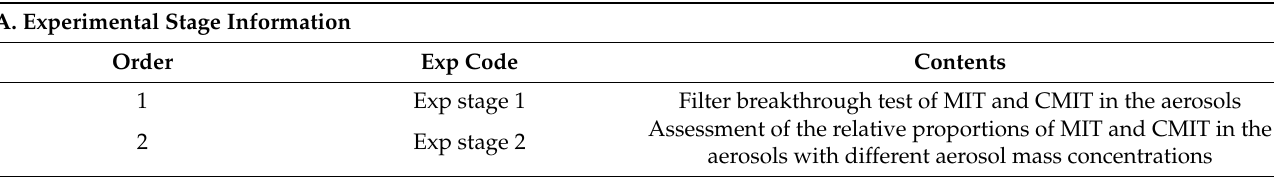
Table 2. Experimental scheme for the testing of the CMIT/MIT aerosol behavior